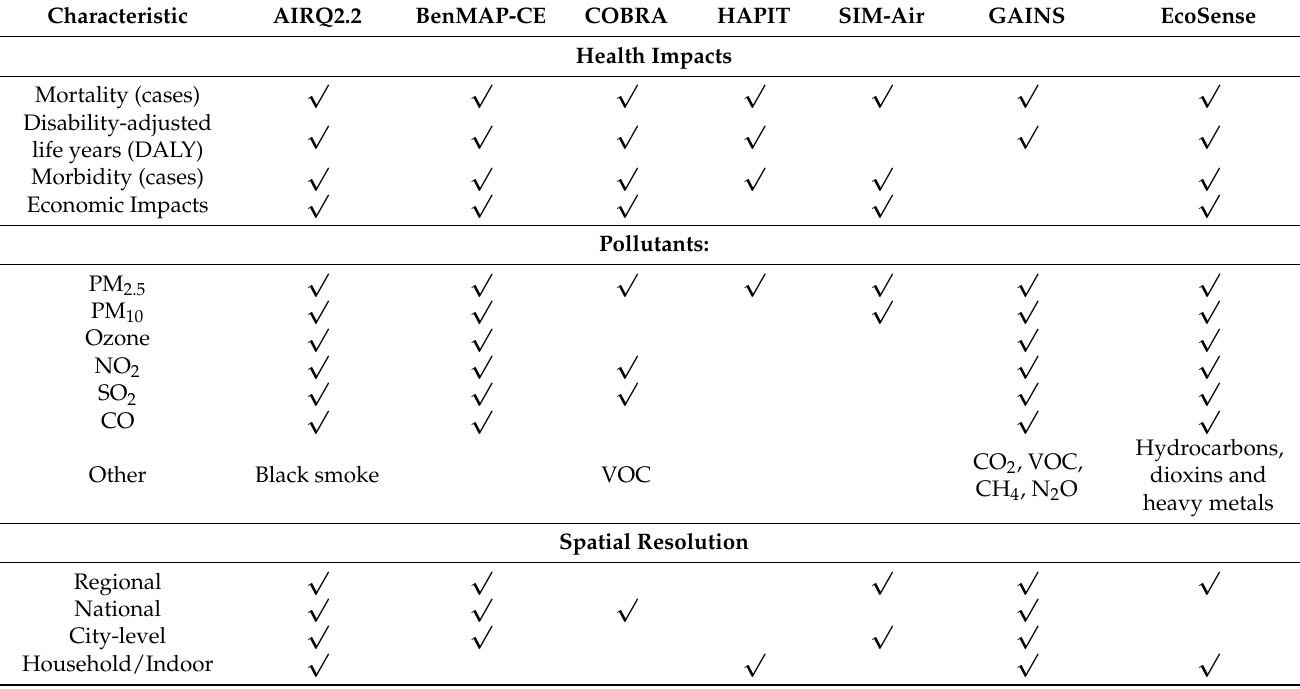
Table 6. Comparison between the AP-HRA